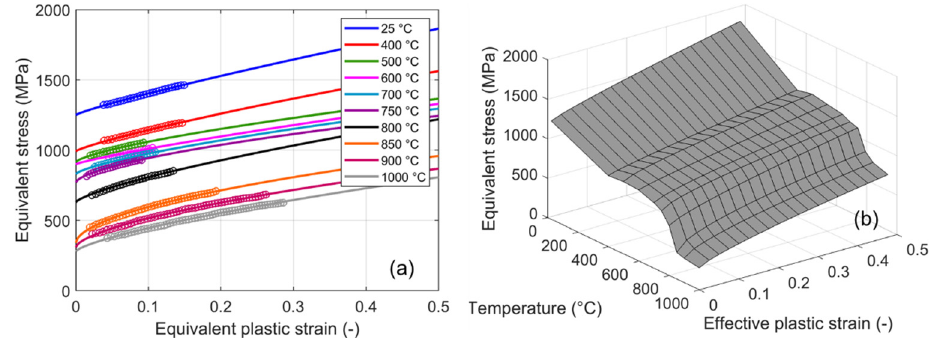
Figure 14. DA specimens: ( a ) comparison between the experimental results in terms of equivalent stress versus equivalent plastic strain obtained from the engineering data (markers) and the fitting models (lines); ( b ) surface obtained for the definition of the high strain rate material response as a function of equivalent plastic strain and temperature.